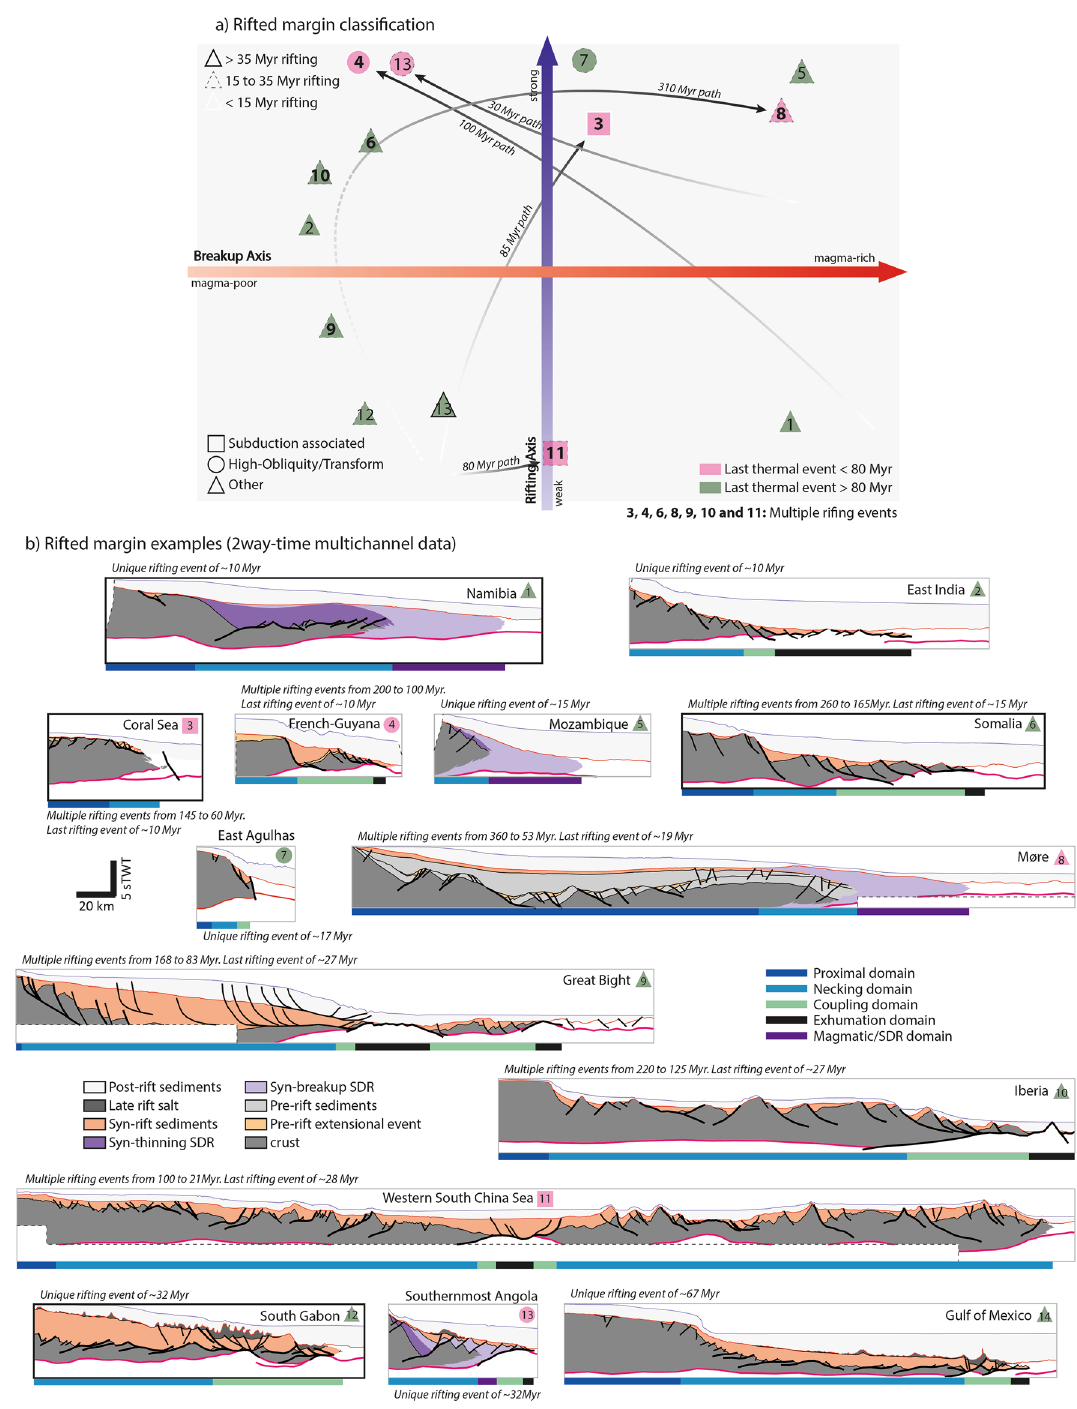
Figure 1. Classification of rifted margins ( a ) and some examples ranked by rifting duration ( b ). The proposed classification is organized along two axes, the rifting axis that characterizes the overall rheology of the crust and the breakup axis that characterizes the quantity of magma involved during the rupture of the lithosphere. The four presented examples, Somalia (6), South Gabon (12), Namibia (1) and Coral Sea (3), are highlighted in a thick black frame. The other sections are either from published work: Great Bight (7) 129 , East India (8) 103,130 , French Guyana (9) 131 , Iberia (11) 13 , Møre (14) 132 ; or from Total internal studies: Southernmost Angola (5, Namibe Basin), Western South China Sea (6), Gulf of Mexico (10, Mexico), Mozambique (12) and East Agulhas (13, South Africa). All lines are located in Fig.